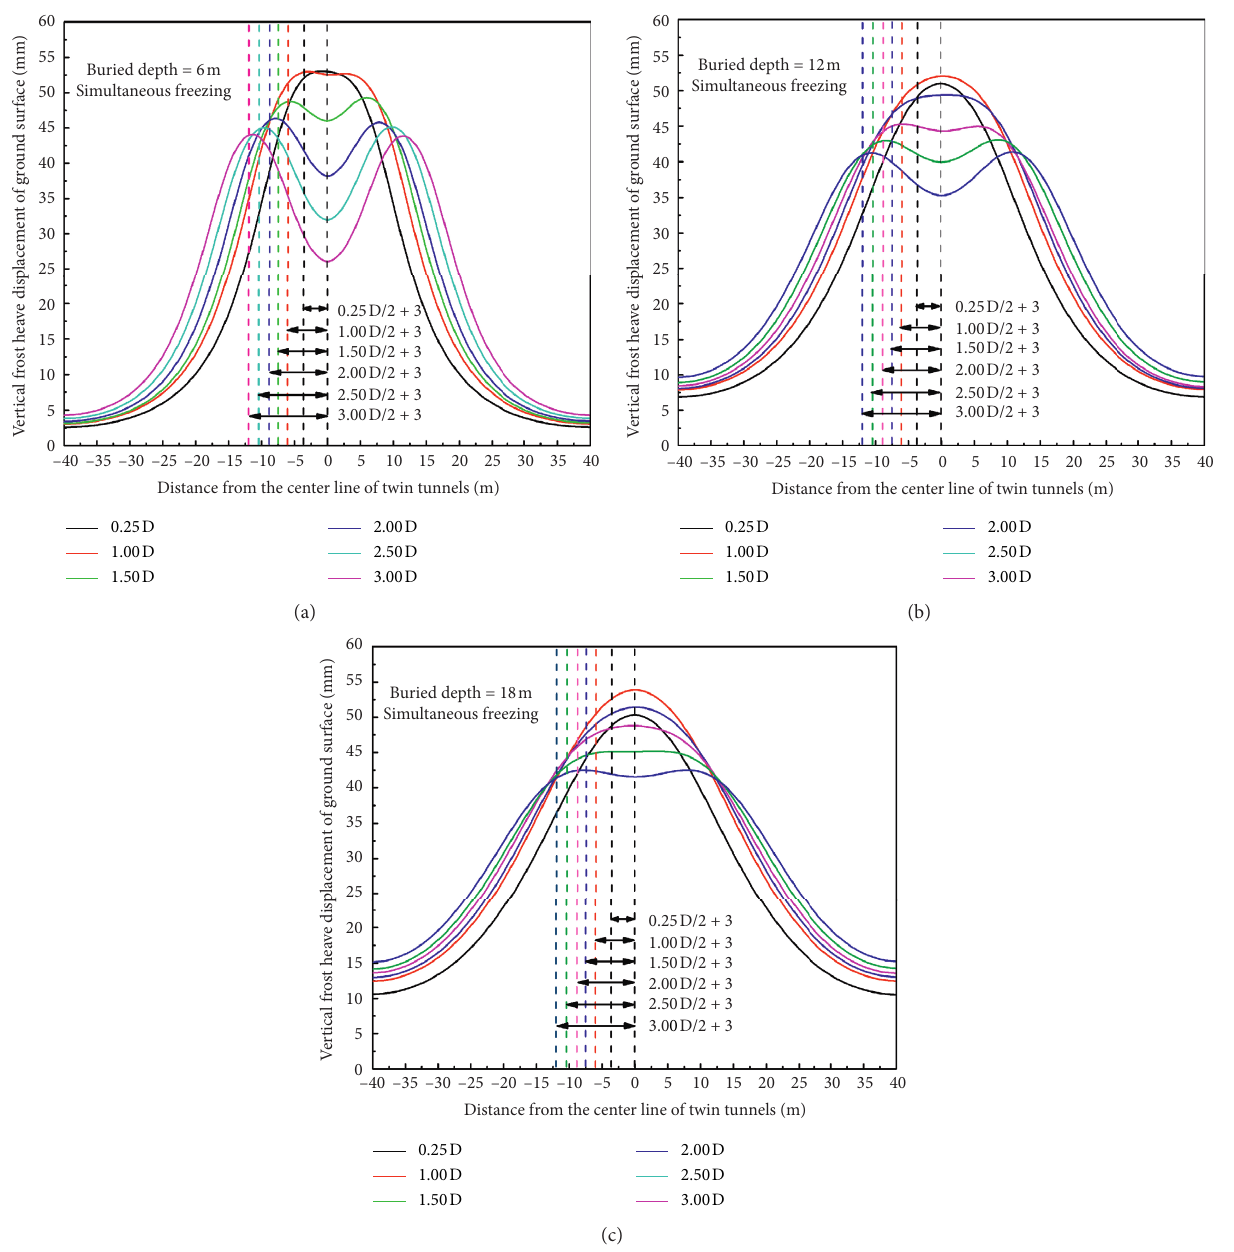
Figure 6: Heaving displacement of the ground